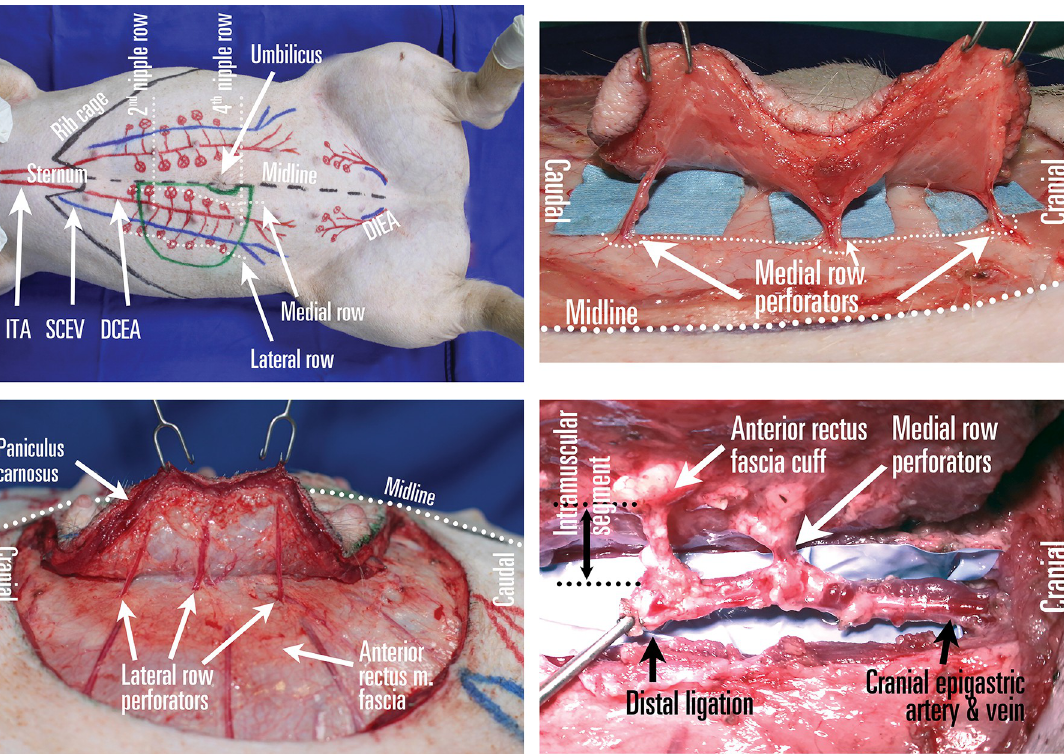
Fig 1. Deep cranial epigastric artery perforator flap planning in pigs. (A) DCEAPf planning between the 2 nd and 4 th nipple line, centered on the deep cranial epigastric artery (DCEA) and including the medial and lateral row of skin perforators. ITA–internal thoracic artery; SCEV–superficial cranial epigastric vein; DIEA–deep inferior epigastric artery. (B) Dissection of lateral row of perforators. (C) Dissection of medial row perforators. Dotted line marks the incision along the anterior rectus muscle sheet. (D) Epigastric artery dissected and transected distal to the skeletonized perforators, with no sign of vessel spasm. Republished from personal archive under a CC BY license, with permission from Dr. Nistor Alexandru, original copyright 2016.